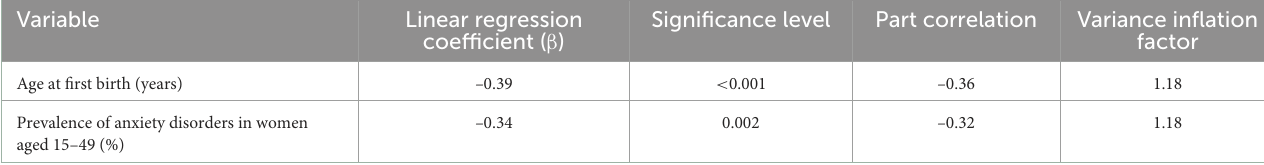
TABLE 5 Stepwise multivariate linear regression analysis of variables significantly associated with national lifetime breastfeeding rates.